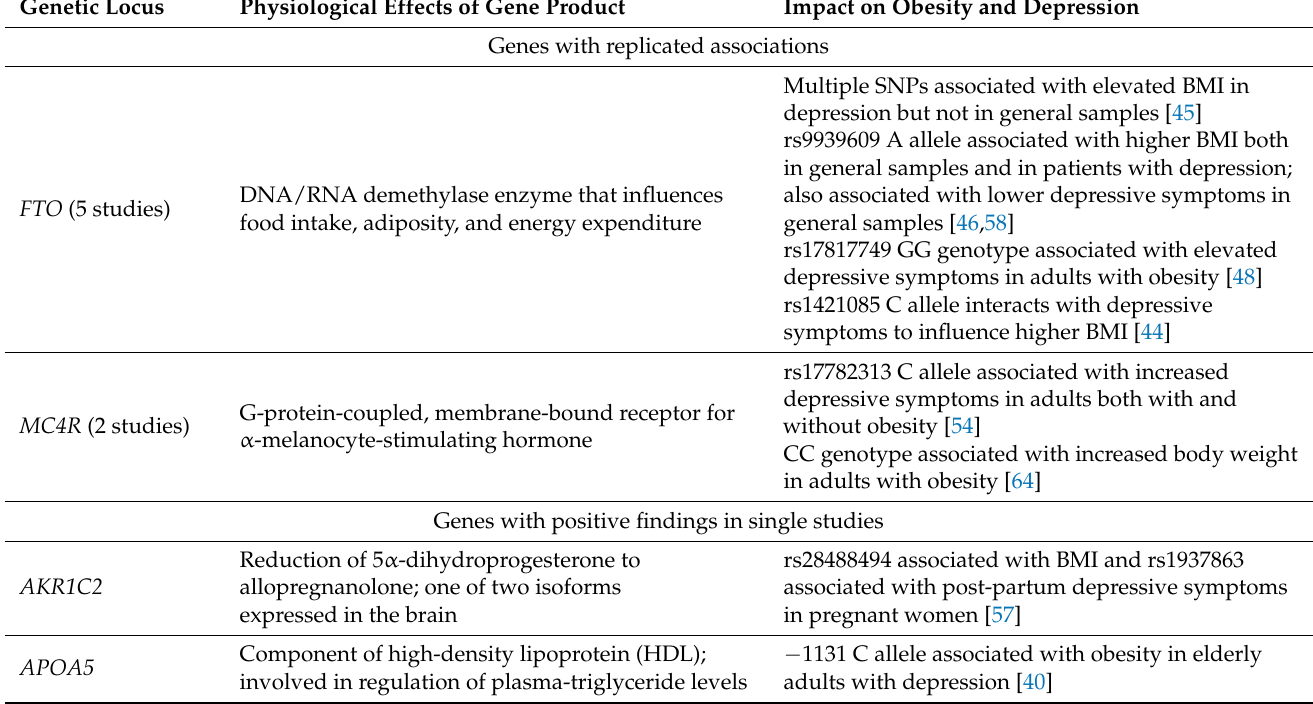
Table 2. Functional significance and quality of evidence for genes associated with both obesity and